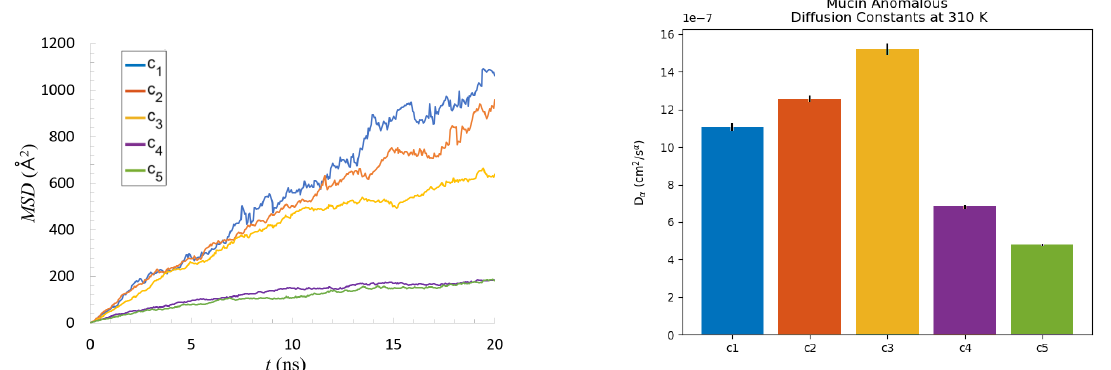
Figure 8. Evolution of the protein MSD in time ( left ) and fitting values of diffusion coefficient D α ( right ) for five concentrations of mucin’s solutions, averaged over all molecules for all iterations of the simulation. Black lines show the STD of the fitting parameters.